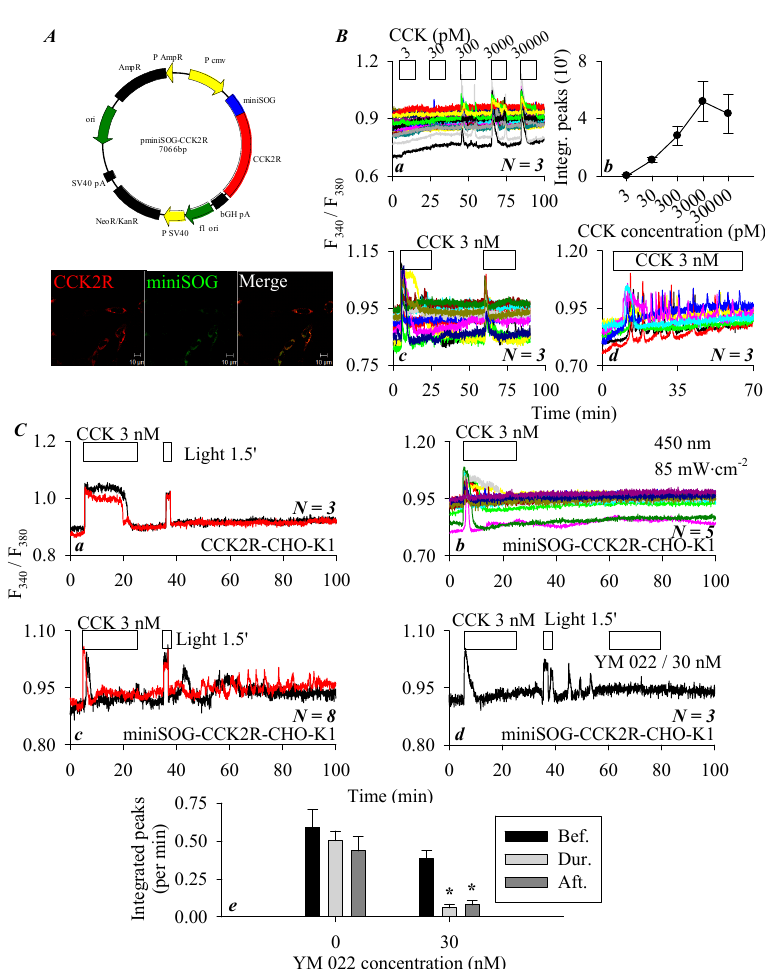
Figure 4. The miniSOG photodynamic activation of CCK2R in CCK2R-CHO-K1 cells. ( A ) CHO-K1 cells were transfected with plasmid pminiSOG-CCK2R ( Aa ). Twenty four (24) h after transfection, miniSOG-CCK2R-CHO-K1 cells were fixed and incubated sequentially with primary goat anti-CCK2R antibody and TRITC-conjugated donkey antigoat secondary antibody (red), before confocal imaging done ( Ab ). Fluorescent and merged brightfield images are shown. Confocal images were taken on a Zeiss LSM 510 META (objective 63 × / 1.40 oil) with λ ex TRITC / 543 nm and λ ex 488 nm. Scale bars are 10 µ m. ( B ) Here, miniSOG-CCK2R-CHO-K1 or CCK2R-CHO-K1 cells loaded with Fura-2 AM were attached to coverslips of Sykes–Moore perfusion chambers and perifused. CCK at 3, 30, 300, 3000, or 30,000 pM, blue-light irradiation (450 nm, 85 mW · cm − 2 ), and YM 022 / 30 nM were applied as indicated by the horizontal bars. ( Ba ) CCK at 3, 30, 300, 3000, or 30,000 pM. ( Bb ) A quantitative analysis was done for the experiments shown in ( Ba ): the calcium peak areas above baseline were calculated and plotted in terms of CCK stimulation per 10 min (5–15, 25–35, 45–55, 65–75, and 85–95 min). ( Bc ) Tandem doses of CCK 3 nM. ( Bd ) Continuous CCK at 3 nM (1 h); ( C ) miniSOG photodynamic activation of CCK2R. ( Ca ) CCK 3 nM and blue-light irradiation (450 nm, 85 mW · cm − 2 , 90 s) in CCK2R-CHO-K1 cells. ( Cb – Cd ) CCK 3 nM ( Cb ), CCK 3 nM, and blue-light irradiation (450 nm, 85 mW · cm − 2 , 90 s) in miniSOG-CCK2R-CHO-K1 cells ( Cc ). CCK 3 nM, blue-light irradiation (450 nm, 85 mW · cm − 2 , 90 s), and YM 022 / 30 nM in miniSOG-CCK2R-CHO-K1 cells ( Cd ). ( Ce ) Quantitative analysis was performed for the calcium tracings shown in ( Cc , Cd ), calcium peak area above the baseline per unit time before, during, and after perfusion with YM 022 was calculated. Student’s t -test was done, and statistically significant di ff erence is indicated by an asterisk (*) at p < 0.05. Representative calcium tracings from one of N identical experiments ( N = 3–8) are shown in ( Ba , Bc , Bd , Ca – Cd